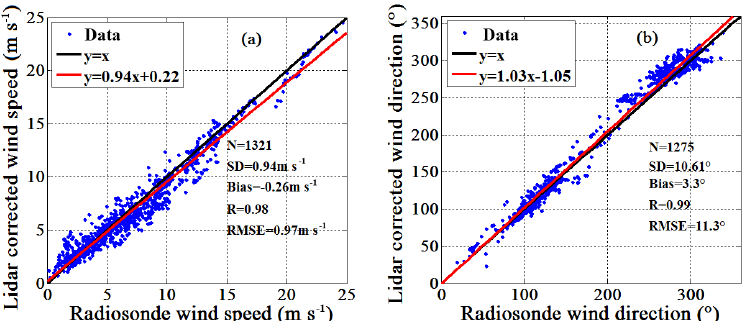
Figure 8. Comparison of (a) wind speed and (b) wind direction between CDL and radiosonde data from 9 to 19 May 2014. The number of points ( N ), standard deviation (SD), bias, correlation coefficient ( R ), and root-mean-square-error (RMSE) are also listed.